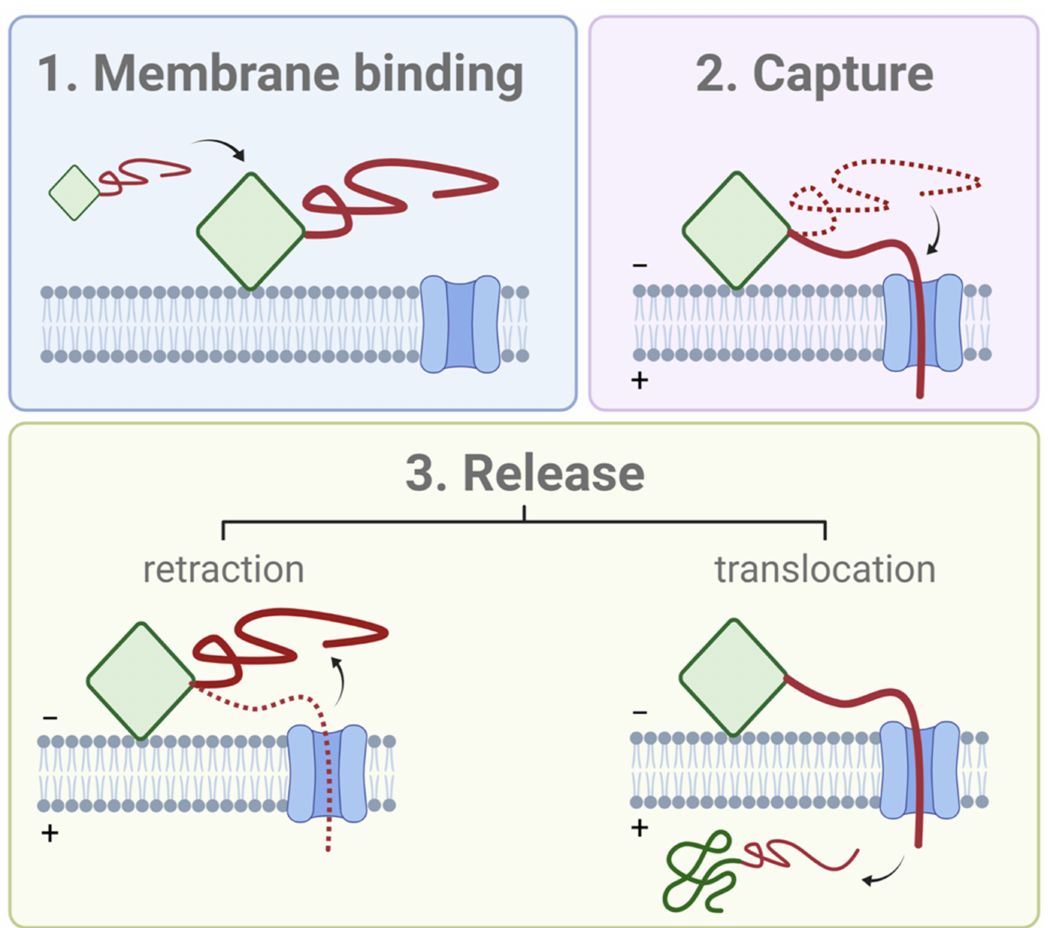
Figure 5. The general model of the structural features of a VDAC inhibitor and its interaction with a voltage-biased VDAC channel. The inhibitor has two domains: a membrane-binding domain (green), which can be structured or not, and a polyanionic, disordered domain (red). Interaction with VDAC begins with (1) recruitment of the inhibitor to the VDAC-containing membrane. (2) The polyanionic domain is captured into the VDAC pore by the transmembrane potential. Finally, (3) the inhibitor is released either by a retraction from the channel or translocation of the entire (unraveled) inhibitor. Created with Biorender.com (accessed on 3 May